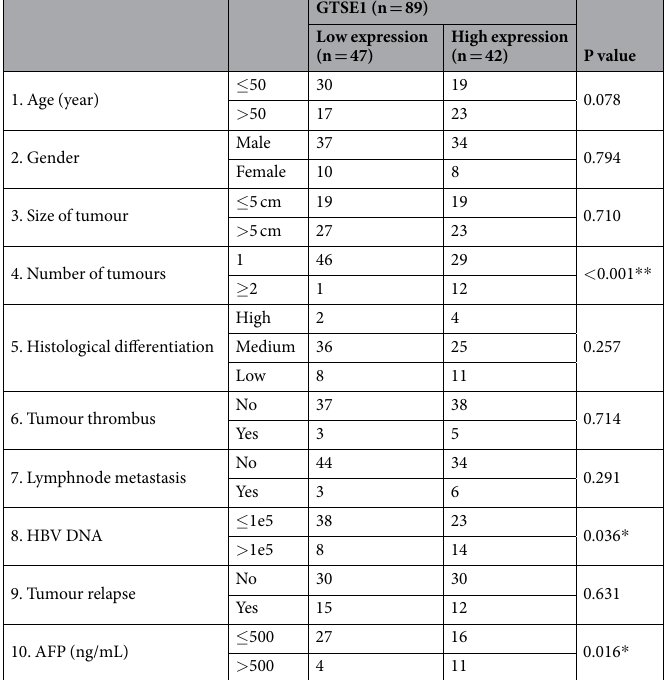
High expression (n = 42)